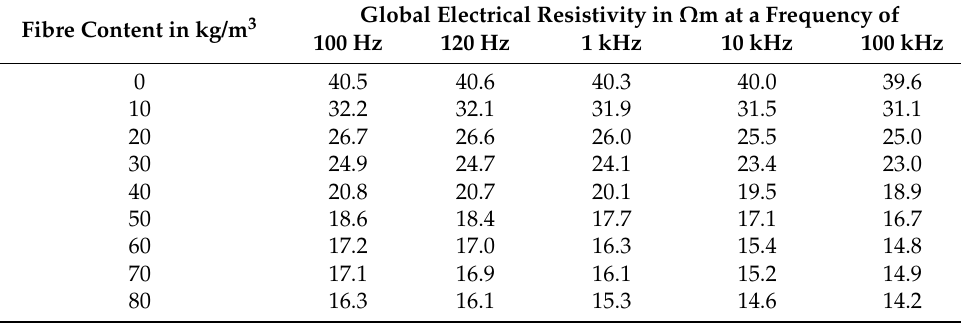
Table A12. Results of the resistivity measurements of the concrete mixture